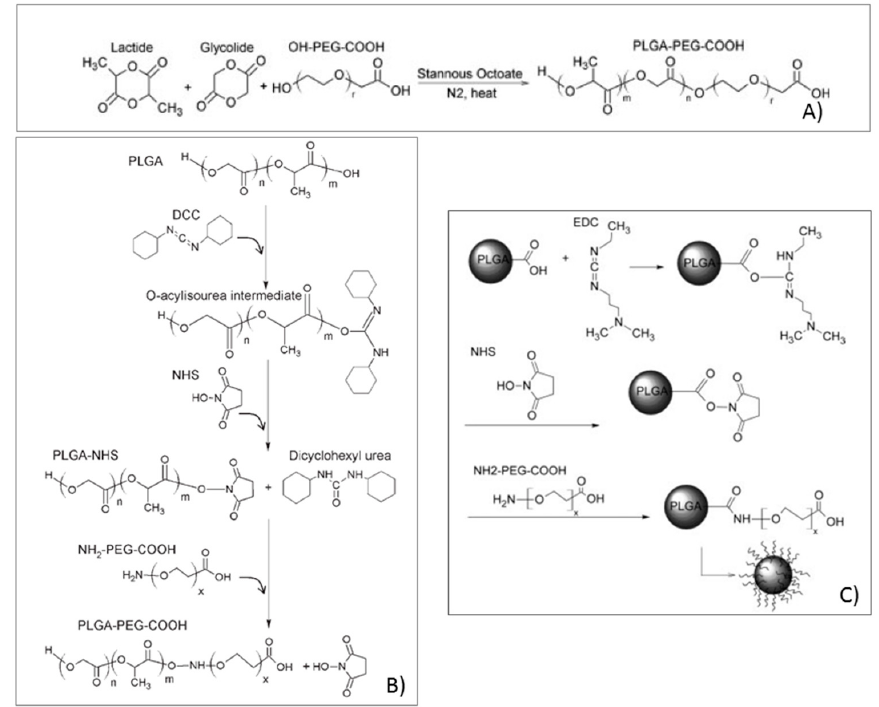
Figure 4. Polyethylenglycol (PEG) conjugation to the polylactide-co-glycolide (PLGA) polymer: ( A ) PEG conjugation throughout the PLGA polymerization reaction; ( B ) PEG conjugation to premade PLGA; ( C ) PEG conjugation to previously formed nanoparticles. (Modified from Bentacourt and co-workers. 2009 [57]).